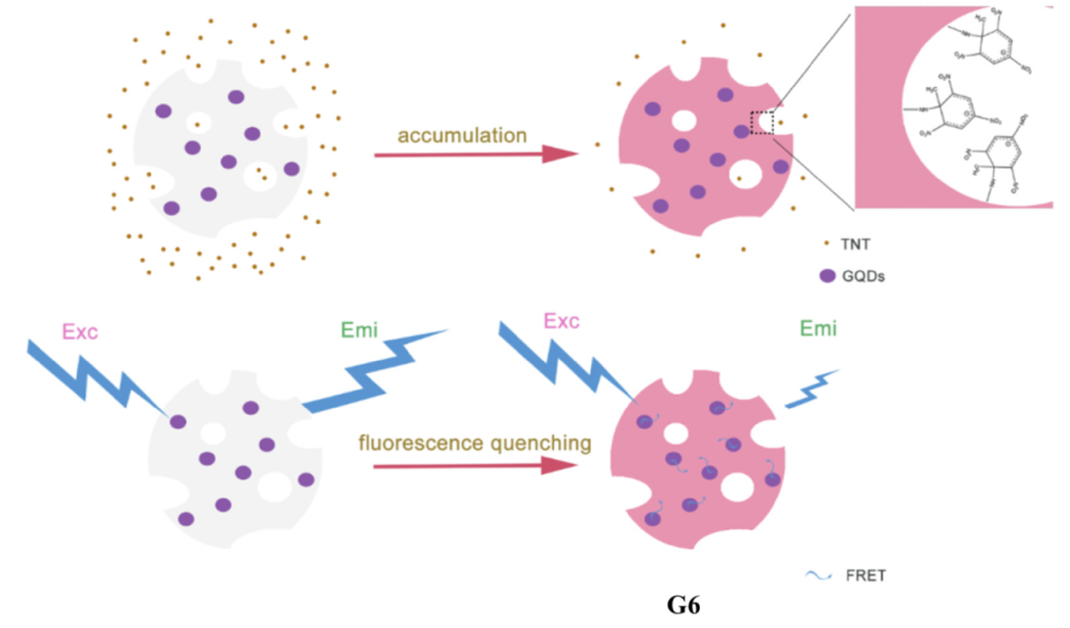
Figure 8. The plausible sensing mechanism of GQDs-APTES ( G6 ) with TNT via the FRET process. Reprinted from [60] with permission from Elsevier.